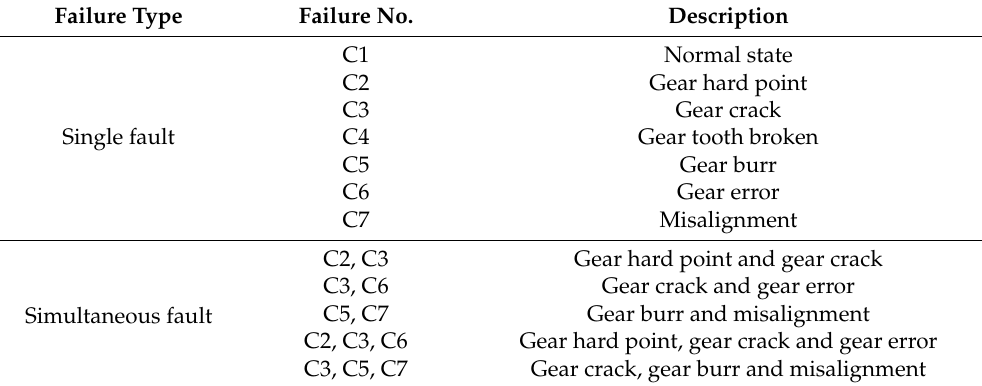
Table 1. Failure modes description.